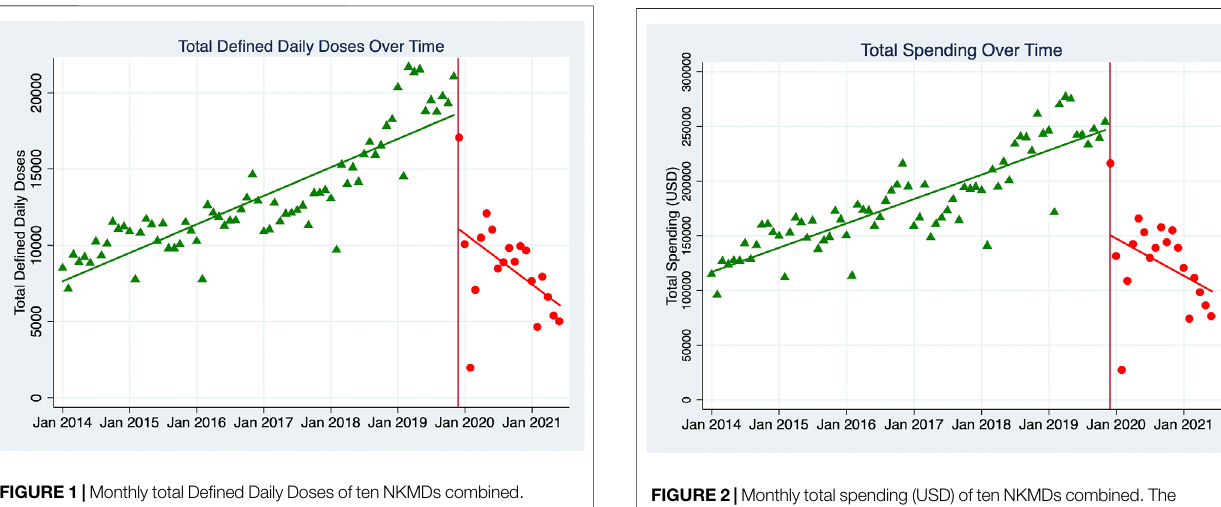
Frontiers in Pharmacology |